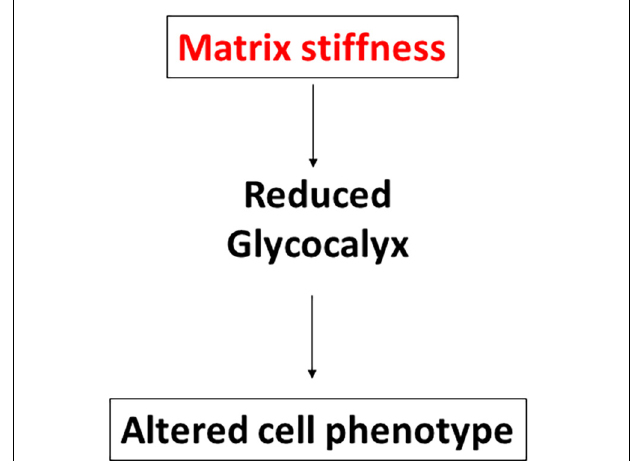
FIGURE 4 | Stiffness inhibits GCX expression in different cell types. Schematic to show that enhanced stiffness inhibits GCX expression through suppressing HS or HA glycosaminoglycan (GAG) expression. Stiffness inhibits the expression of the GCX core protein Glypican 1. The reduction of GCX expression subsequently alters endothelial cell